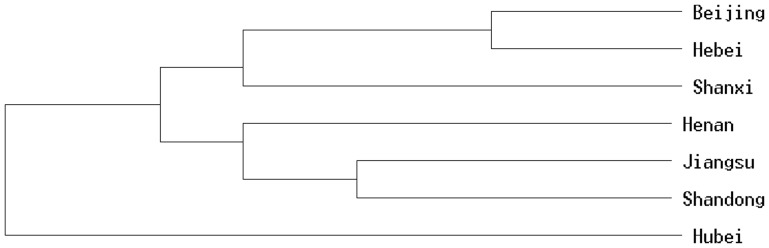
UPMGA Phylogenetic tree of seven different S. avenae geographic populations in China.